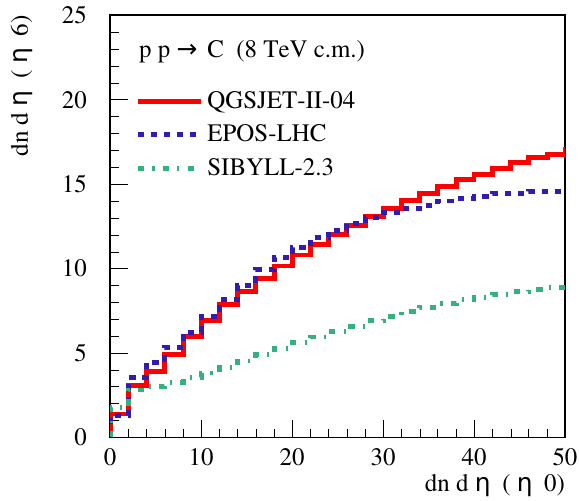
Figure 4. Pseudorapidity density of produced charged hadrons = 6 ( p / d η η dn ch at t > 0) as a function of dn pp | | | | ( p t > 0 . 1 GeV) in pp collisions at √ s = 8 TeV, as calculated using the QGSJET-II-04, EPOS-LHC, and SIBYLL-2.3 models (solid, dashed, and dashed-dotted lines